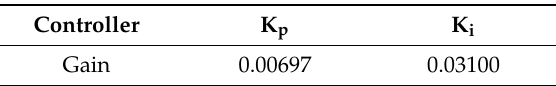
Figure 11. The results of the comparison between the mathematical model and the experimental results of the DC motor.